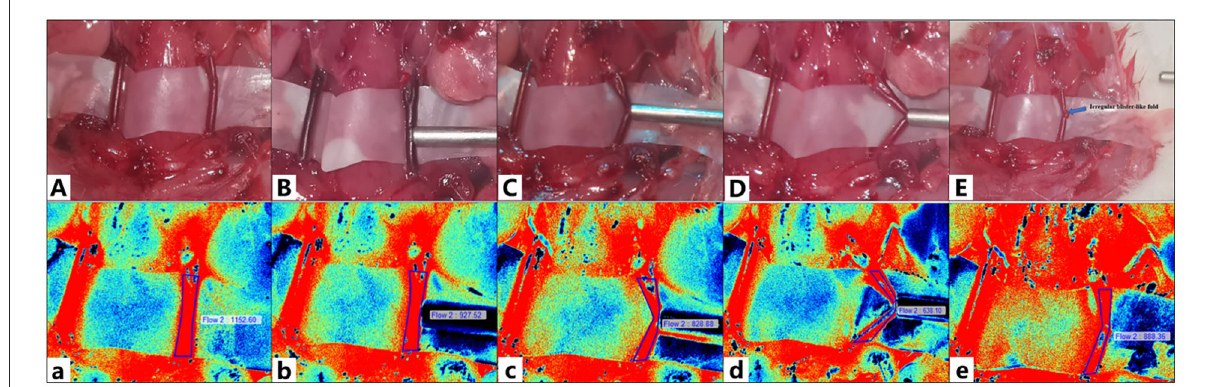
FIGURE4 The camera captured (A–E) . Laser speckle contrast imaging (LSCI) was used to capture (a–e) . (A,a) The carotid artery and its blood flow before suction. (B,b) Type A deformation of blood vessels. (C,c) Type B deformation of blood vessels. (D,d) Type C deformation of blood vessels. (E,e) The carotid artery and its blood flow after suction. The blue arrow indicates an irregular blister-like fold on the vessel wall.